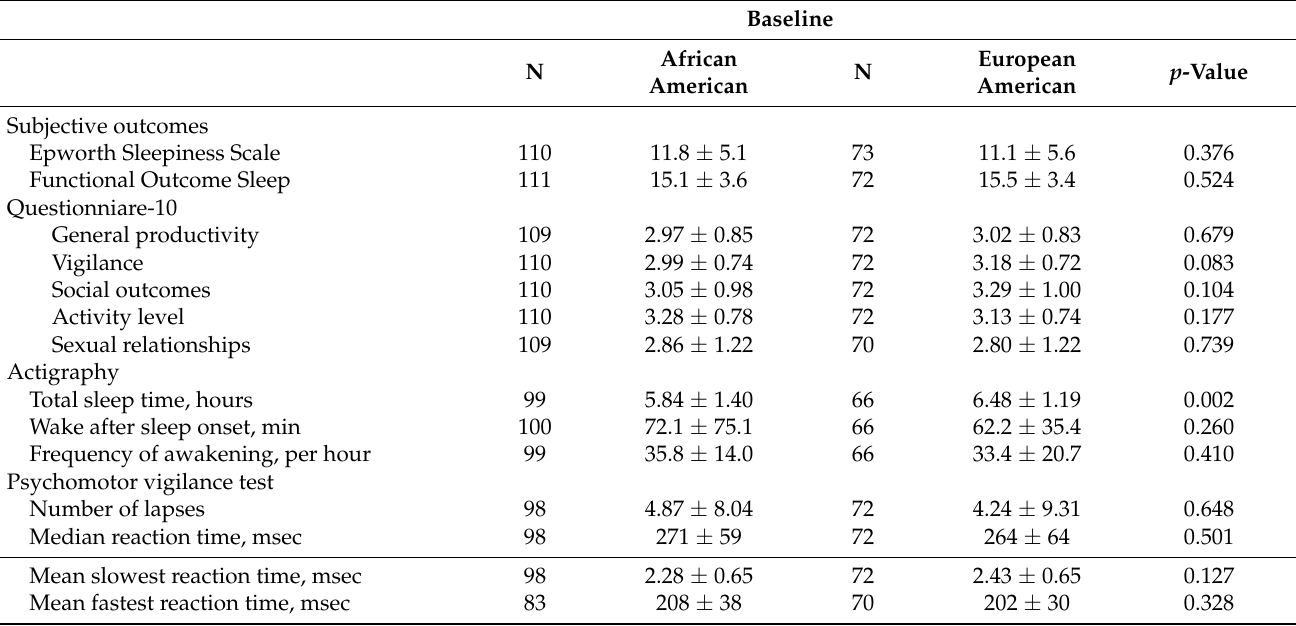
Table 2. Comparison of outcome variables between African American and European American groups at baseline.